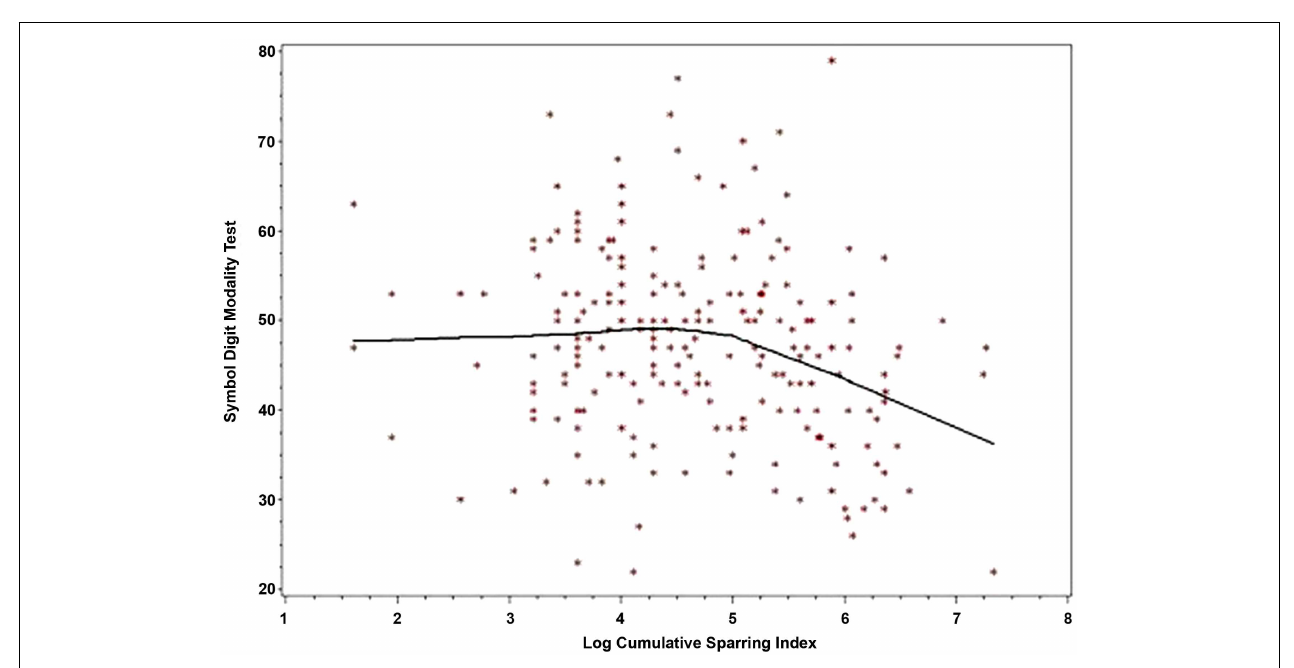
FIGURE 1 | Symbol digit modality by log cumulative sparring index with loess fit